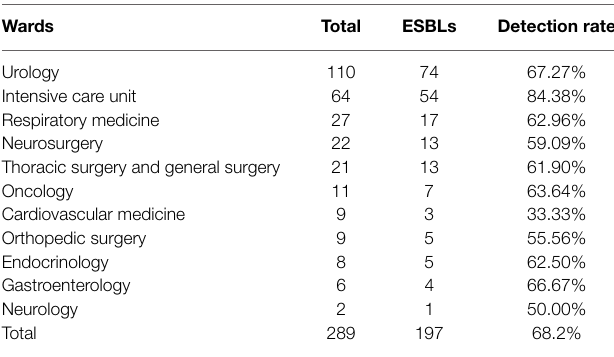
TABLE 1 | Distribution of strains in different wards.